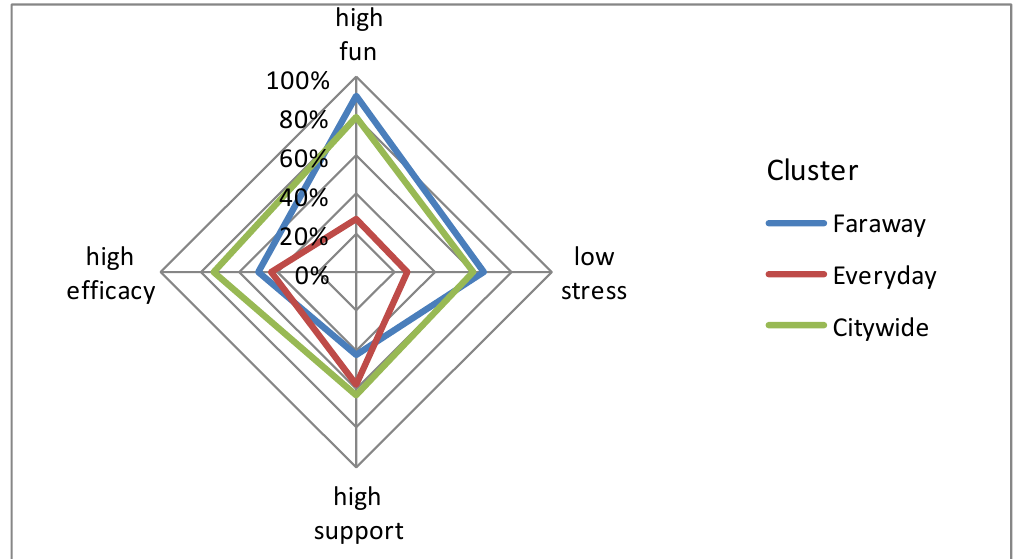
Figure 4. The probability of experiencing high wellbeing by cluster